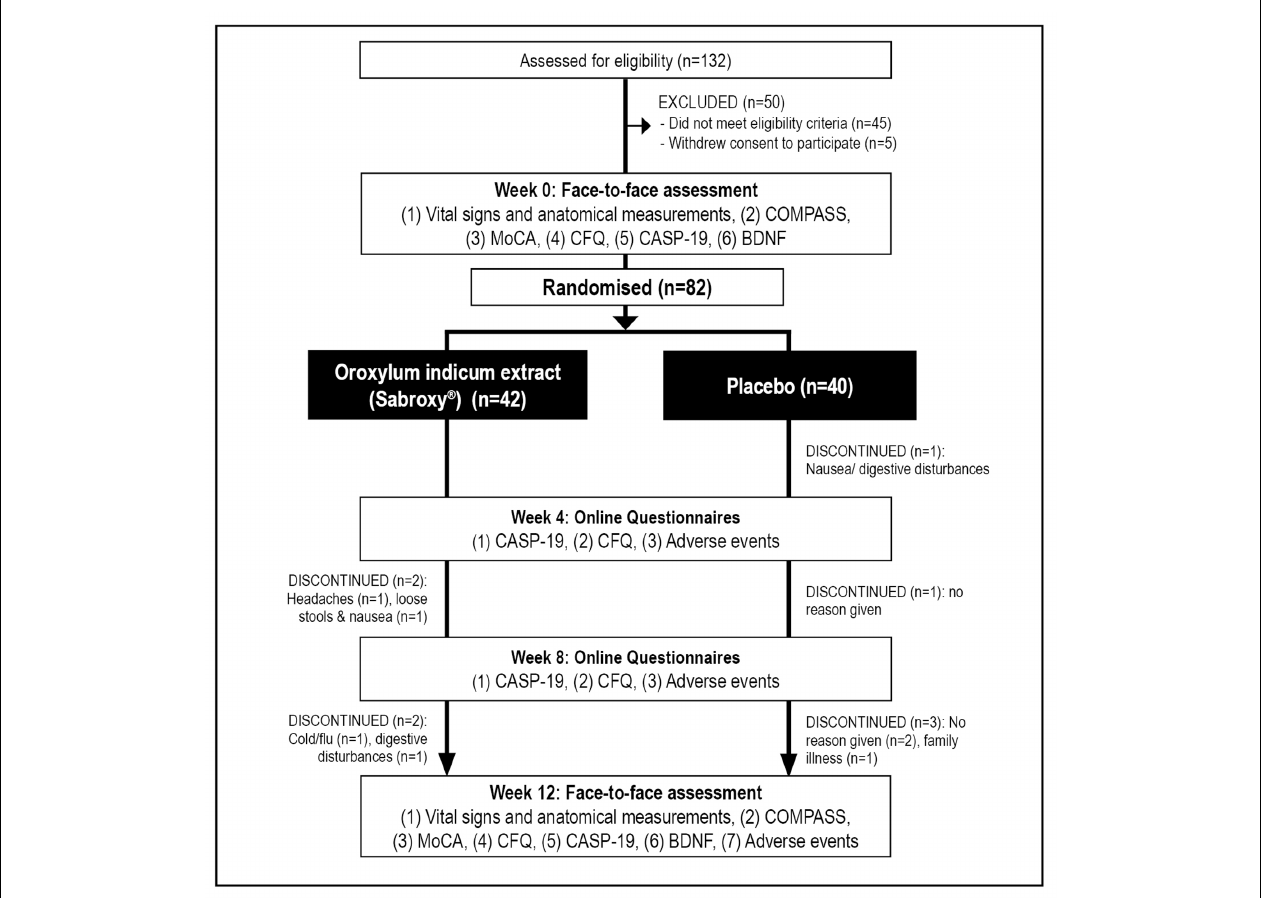
FIGURE 1 | Systematic illustration of study design. BDNF, Brain-derived neurotrophic factor; CASP-19, Control, Autonomy, Self-Realization, and Pleasure; CFQ, Cognitive Failures Questionnaire; COMPASS, Computerized Mental Performance Assessment System; MoCA, Montreal Cognitive